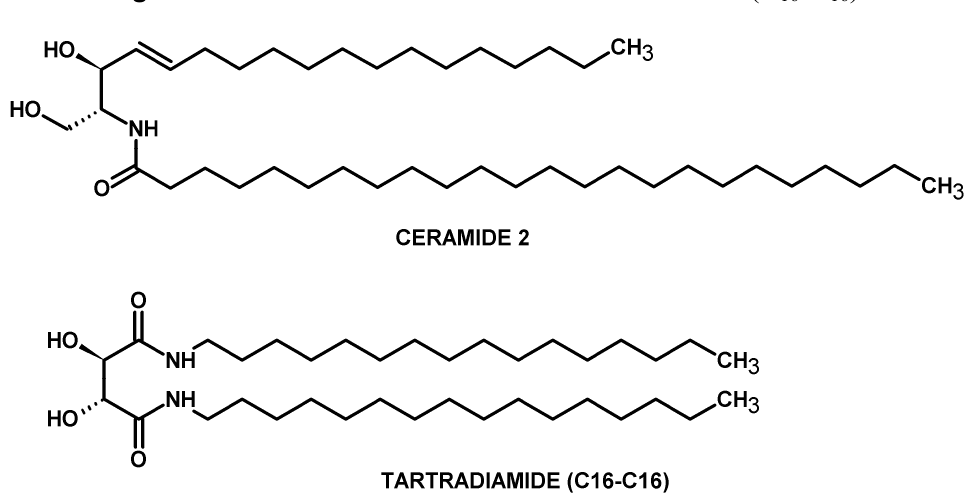
Figure 1. The structure of ceramide 2 and tartramide (C